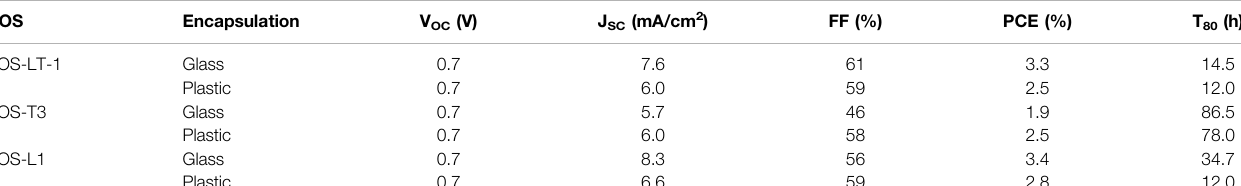
TABLE 4 | Summary of the main parameters of the solar cells after fabrication and at T 80 for the three ISOS-LT-1, -T3, and -L1, for devices with 1 cm 2 active area. ISOS